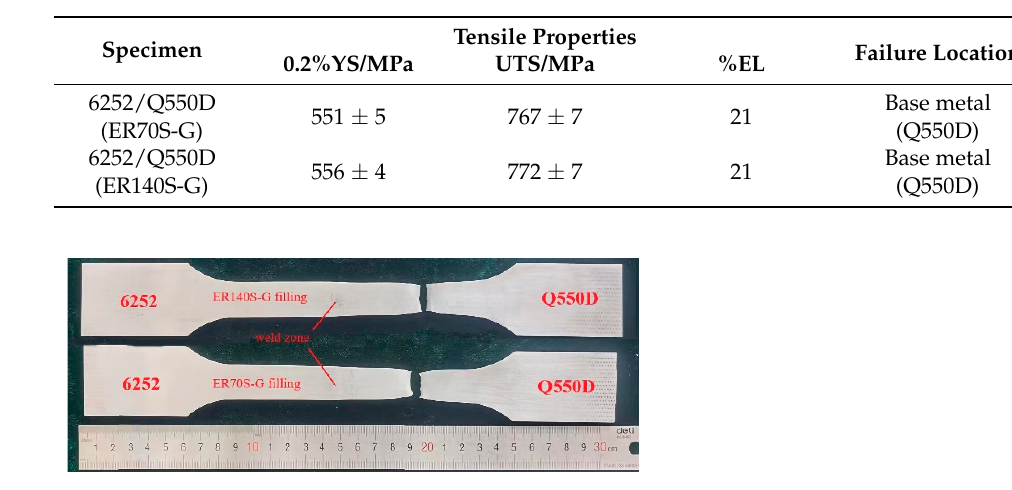
Figure 9. Failure zones of dissimilar welds of